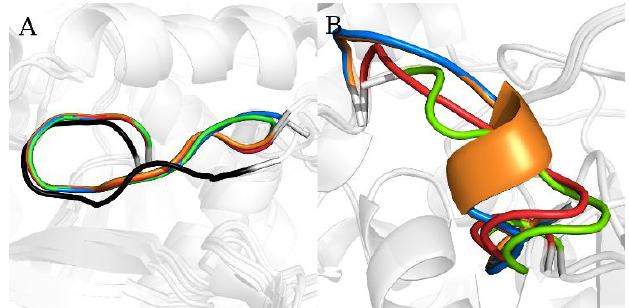
Figure 2. The loop models of reconstructed ( A ) static and ( B ) flexible loops. The SL_m1 and FL_m1 models are blue, SL_m2 and FL_m2 are red, SL_m3 and FL_m3 are green, SL_mDOPE and FL_mDOPE are orange, and the WT model of the SL is black. The protein is shown in cartoon representation and colored white.